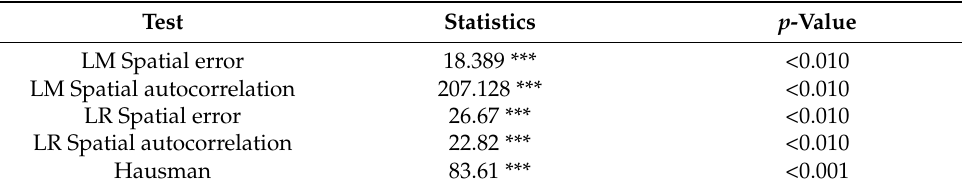
Table 6. LM, LR and Hausman tests of the spatial econometric